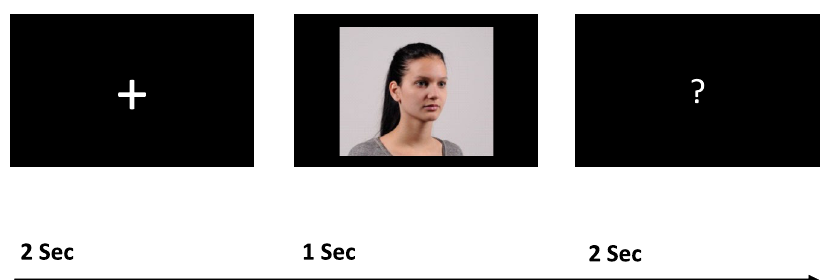
Figure 1. Schematic time course of the experimental paradigm. Participants saw faces of themselves, a friend, or a stranger and were asked to indicate the direction of the face (left or right) when the questionmark sign appeared. The depicted person served as a participant’s friend and did not take part in the experiment; written permission was